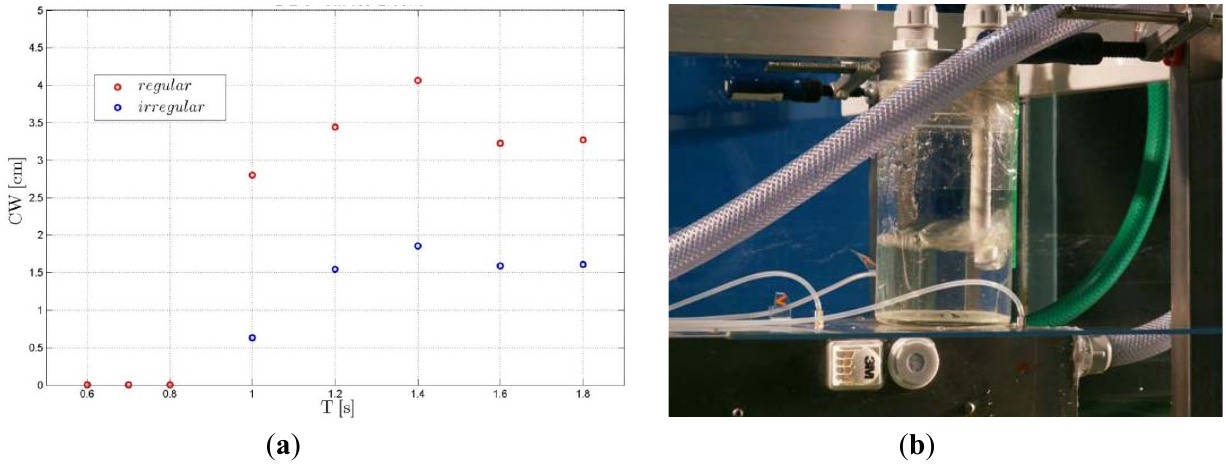
Figure 16. ( a ) Capture width for regular and irregular wave attacks, with the load loss induced by the system shown on the right; ( b ) glass bottle with pipe submerged 1.5 cm, through which air is